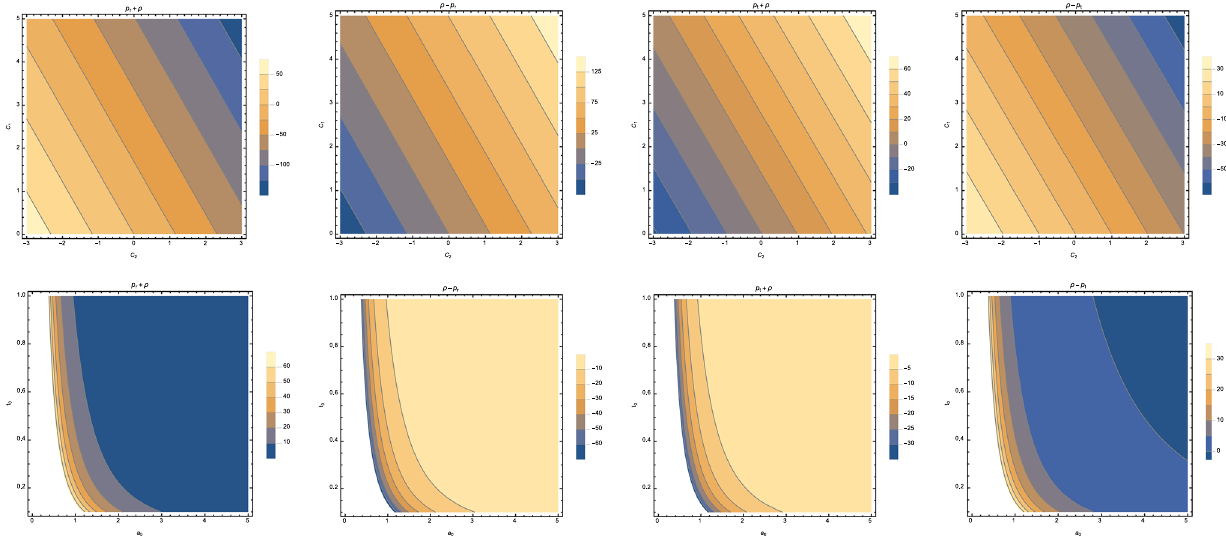
Fig. 4 The above panels shows the variations in ρ ± p r and ρ ± p t w.r.t changing parameters corresponding to Eq. (23). Here C 1 , C 2 is taken with agreement to the constraints set by f ( R ) viability